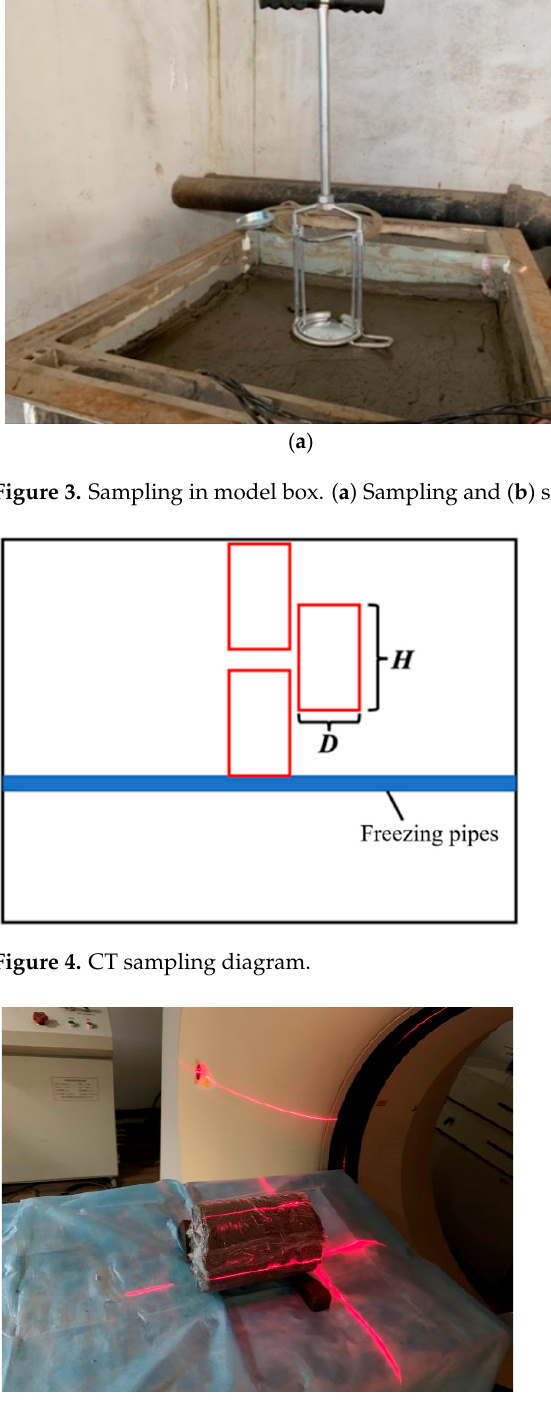
Figure 5. CT scan sample.